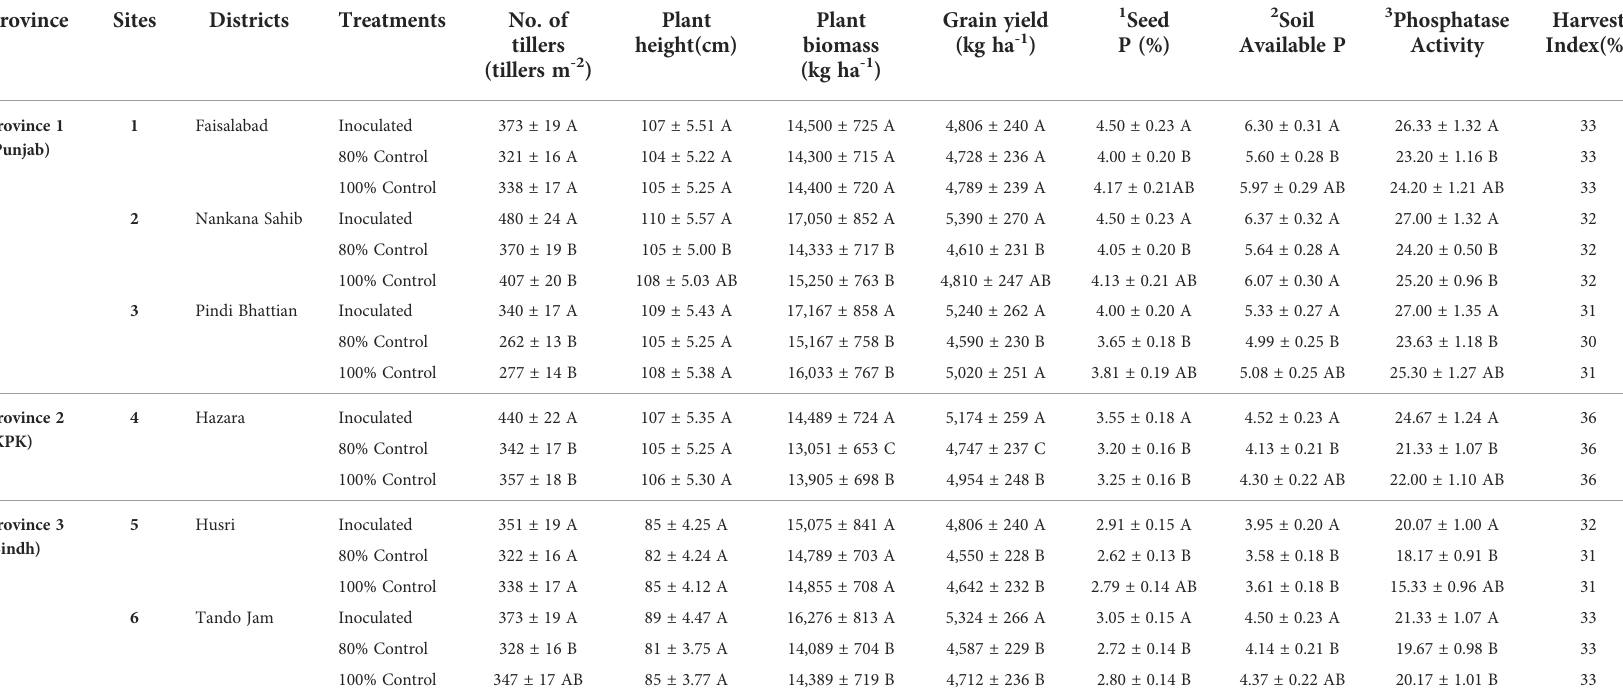
Grain yield (kg ha -1 )